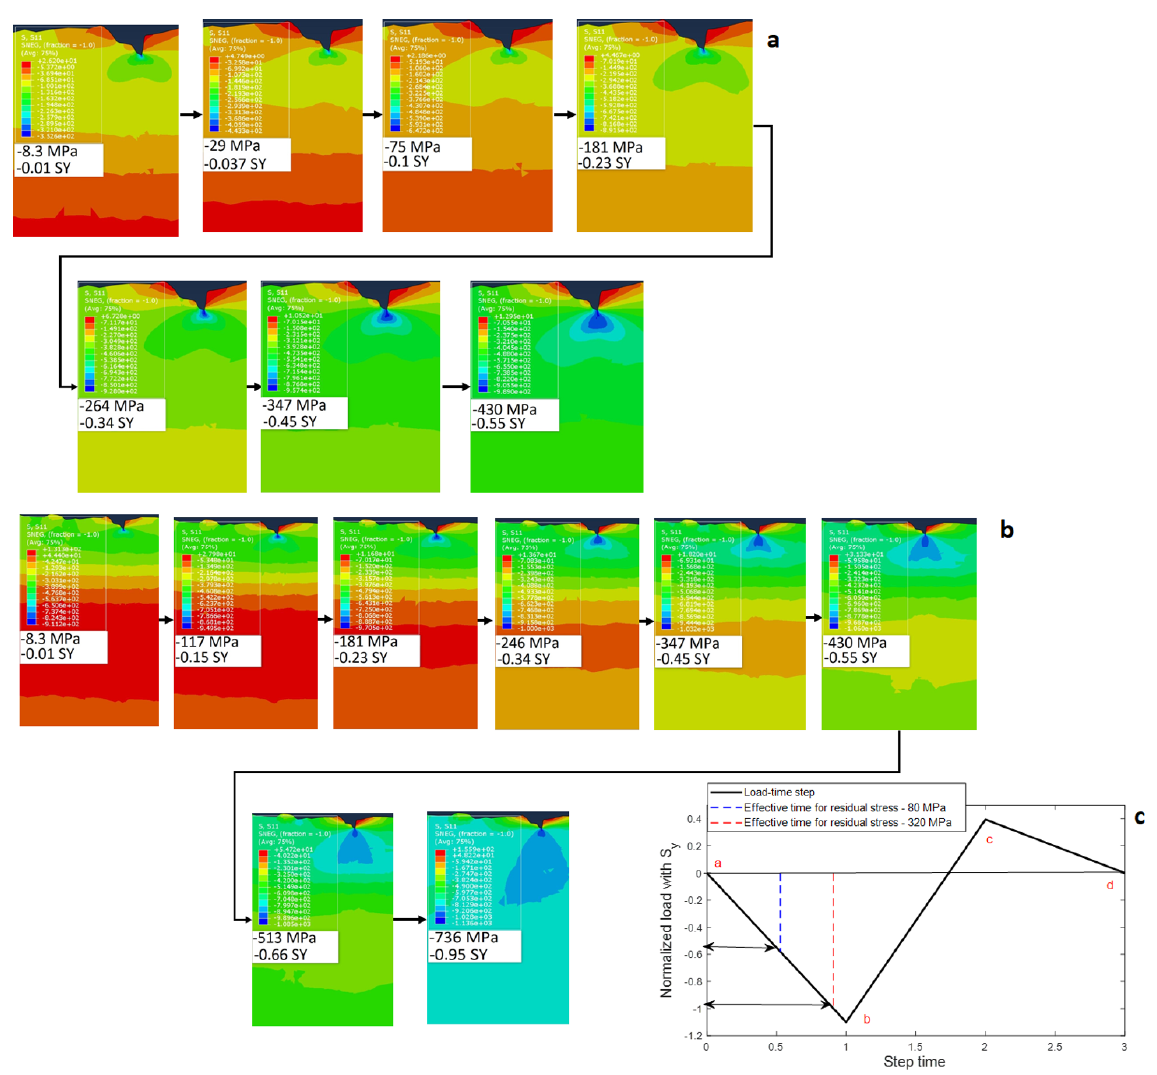
Figure 17. The stress distribution at different time steps of loading for an overload magnitude 1.15 S y before relaxation of the residual stress: ( a ) with residual stress −80 MPa, and ( b ) with residual stress −320 MPa. ( c ) The effective time for different residual stress values before relaxation.